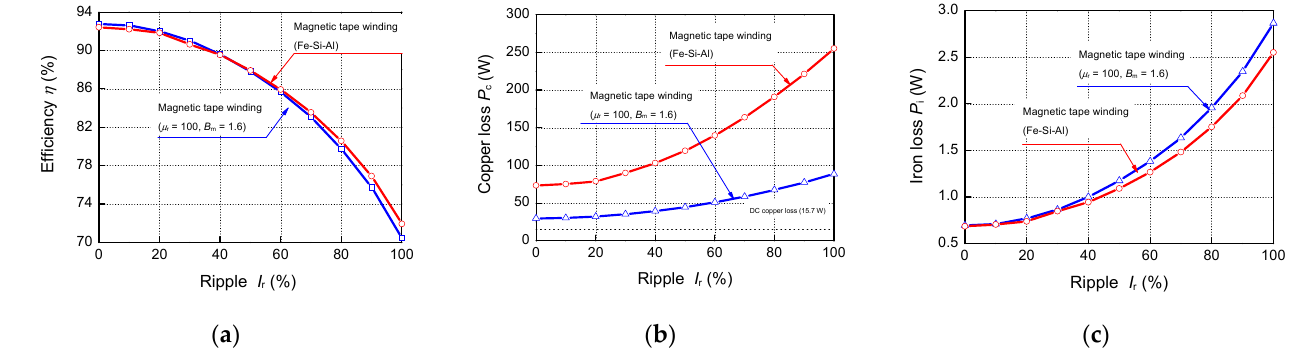
Figure 16. Comparison of tape-dependent motors losses ( P o = 10 kW, N r = 10,000 rpm). ( a ) efficiency; ( b ) copper loss; ( c ) iron loss.